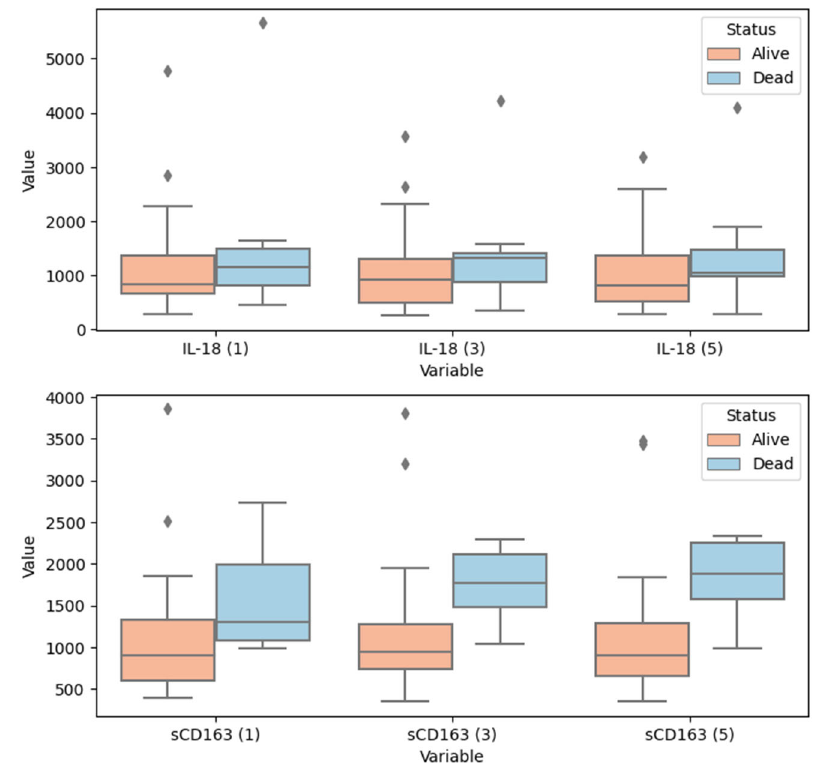
Figure 2. Boxplot of values of serum concentrations of IL ‐ 18 and sCD163 over five days (labelled in ‘()’ brackets in the variable names) since hospital admission in patients with diagnosed sepsis—in context of in ‐ hospital survival. Fliers indicate outliers. IL ‐ 18, interleukin 18; sCD163, soluble CD163. Descriptive statistics and p ‐ values associated with this plot are given in Table 5.